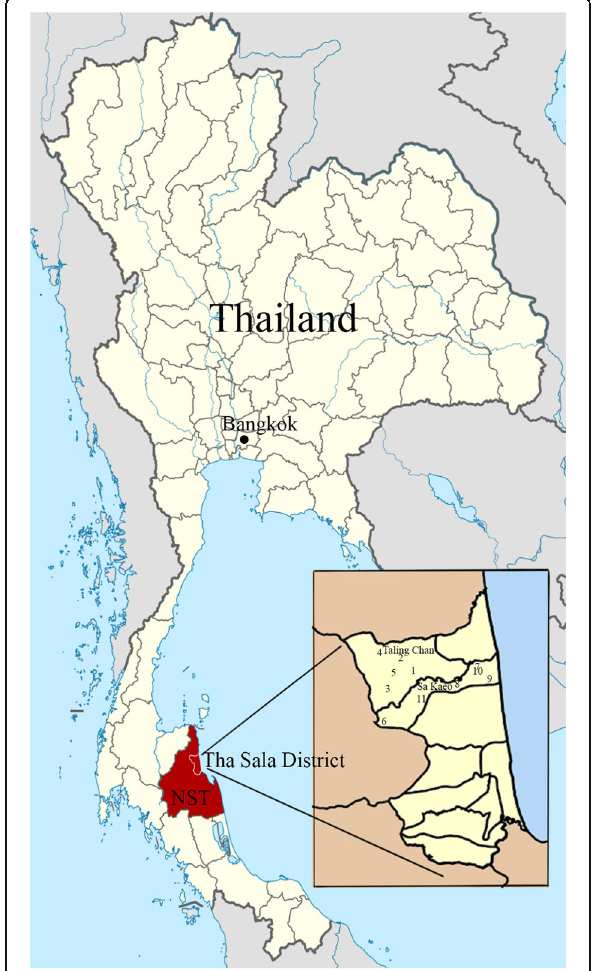
Fig. 1 Map of the Taling Chan and Sa Kaeo subdistricts in the Tha Sala District, Nakhon Si Thammarat (NST) Province, Southern Thailand. Numbers 1 to 11 are the coordinates of each selected school in this study (map from Wikipedia: https://de.wikipedia.org/ wiki/Datei:Thailand_Nakhon_Si_Thammarat_locator_map.svg and